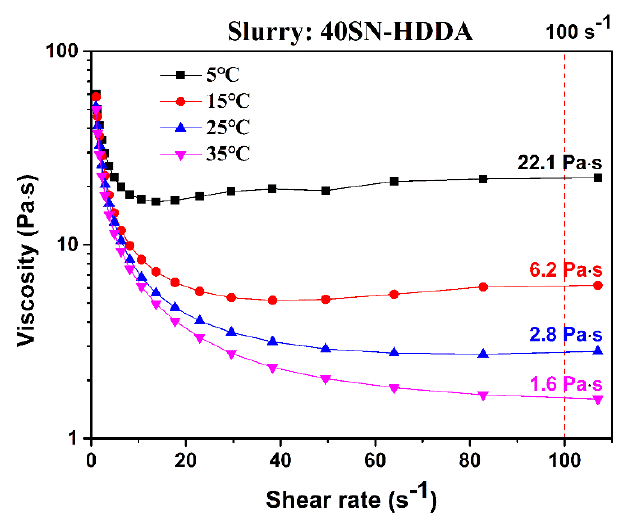
Figure 4. Rheological property of the 40SN-HDDA slurry at different temperature. Table 3. The influence of powder type with di ff erent refractive index on slurry curing ability.